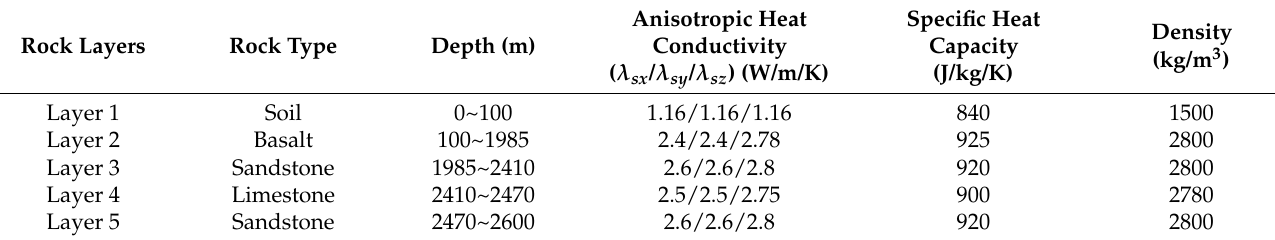
Table 1. Thermo-physical properties of rock layers.